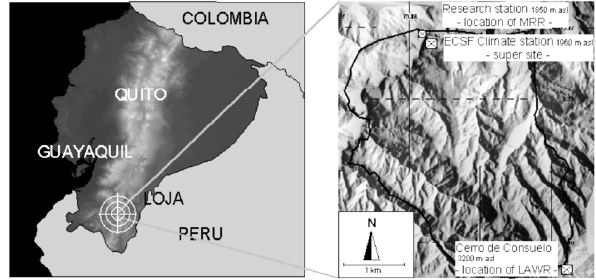
Fig. 1. Map showing the research area in